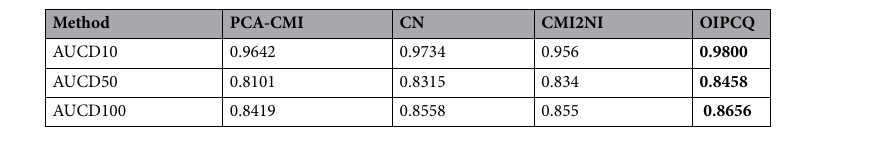
Table 10. Comparison of different methods for learning DREAM3. Best results are indicated in bold. AUCD10 AUC value for a 10-gene network in DREAM3, AUCD50 AUC value for a 50-gene network in DREAM3, AUCD100 AUC value for a 100-gene network in DREAM3.